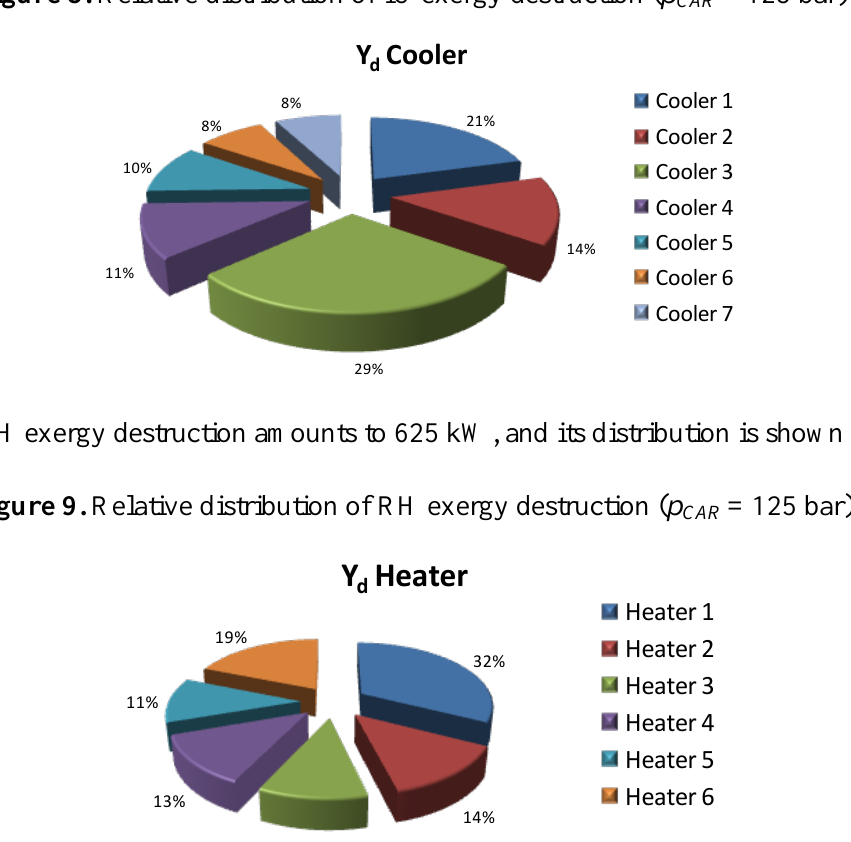
Figure 8. Relative distribution of IC exergy destruction ( p